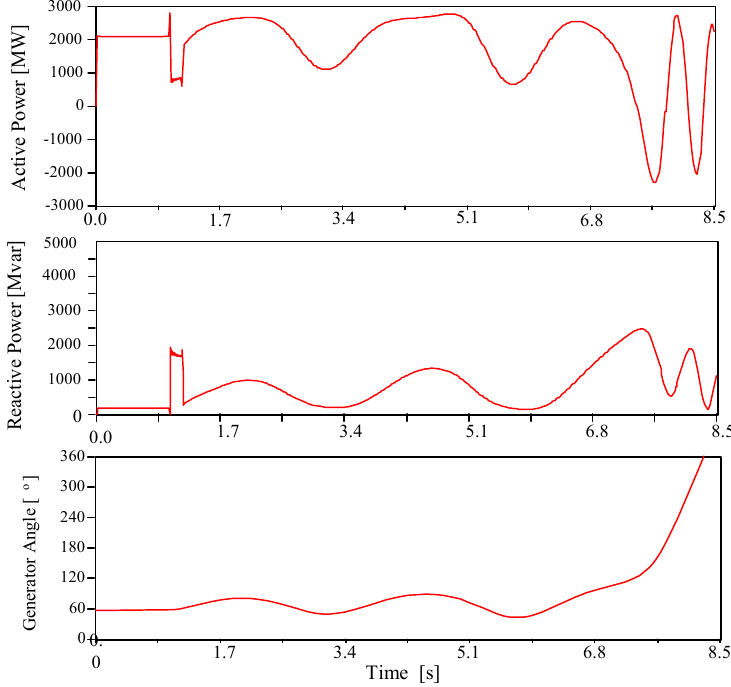
Figure 12. The time variation of generator angle δ and reactive power Q after the inception of the fault.